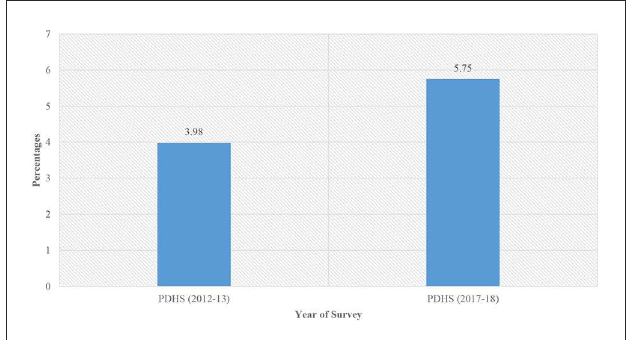
FIGURE1 Trend in stillbirth in Pakistan from the PDHS from 2012 to 2013 to the PDHS from 2017 to 2018.